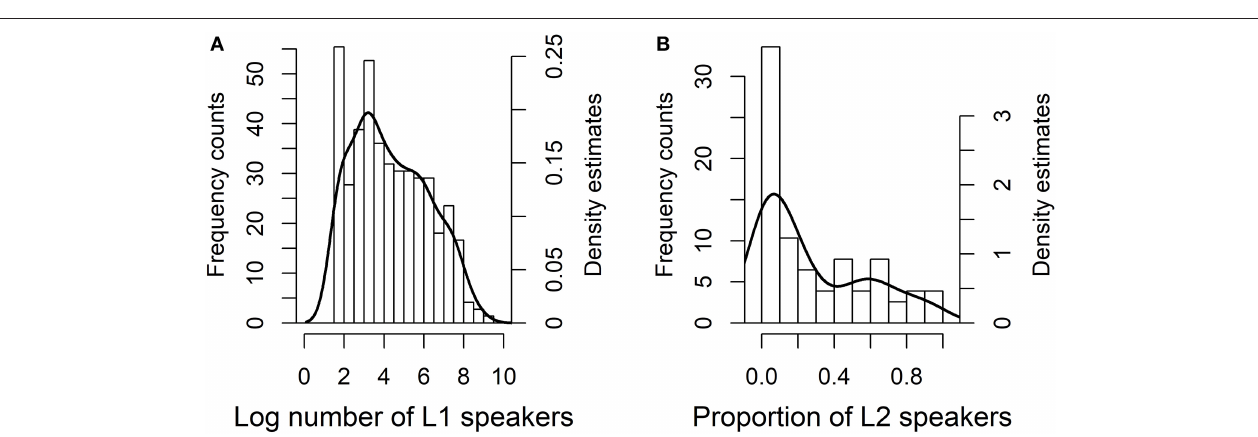
FIGURE 4 | Frequency histograms and superimposed density estimates for the independent demographic variables in case study 1, for log number of native speakers on the left (A) and for the proportion of L2 speakers (including semi-speakers) on the right (B) .